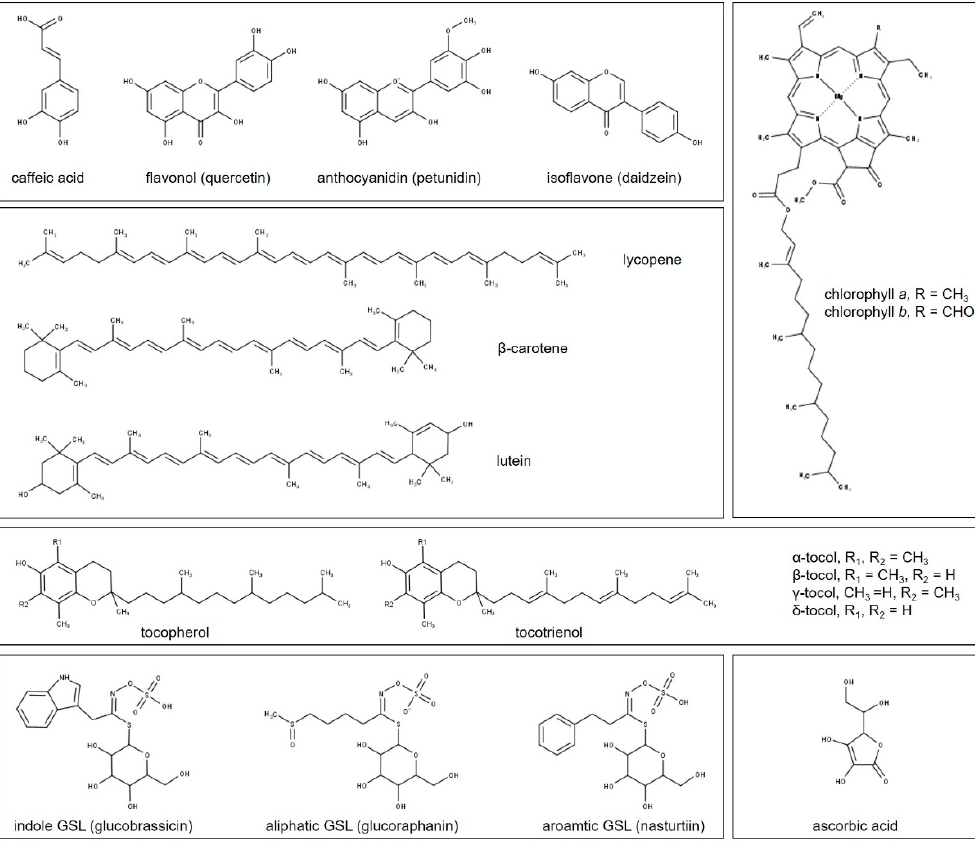
Figure 3. Examples of secondary metabolites whose content is modulated by the different light wavelengths: phenolic compounds (hydroxycinnamic acids and flavonoids), carotenoids, chlorophylls, tocopherols and tocotrienols, ascorbic acid, and glucosinolates. Marvin was used for drawing the chemical structures (Marvin 17.21.0, ChemAxon. Budapest, Hungary).